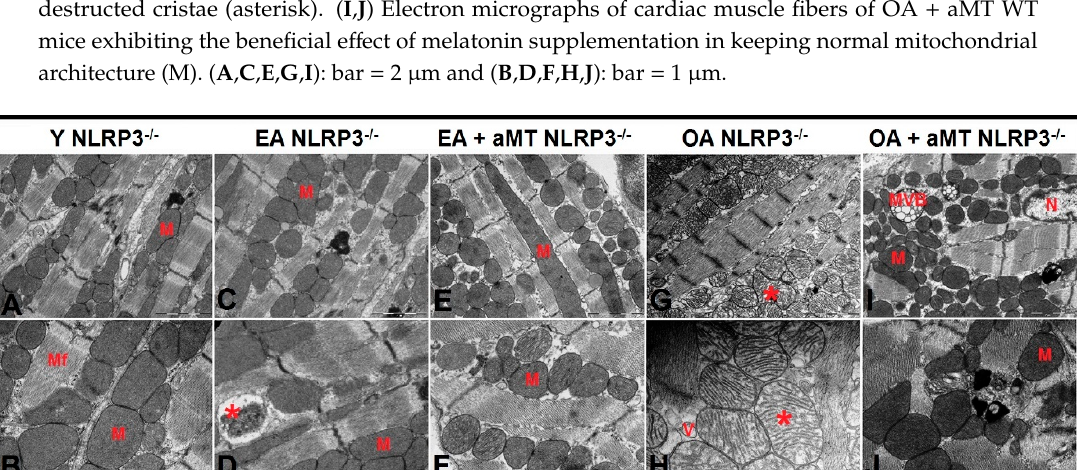
Figure 7. Age-related ultrastructural changes of mitochondria in cardiac muscle fibers of NLRP3 − / − mice and melatonin treatment. ( A , B ) Electron micrographs of cardiac muscle fibers of Y NLRP3 − / − mice showing the presence of normally highly compacted mitochondria with densely packed cristae (M) distributed among myofibrils (Mf). ( C , D ) Electron micrographs of cardiac muscle fibers of EA NLRP3 − / − mice demonstrating intact mitochondria (M) with individual ones depicting damaged peripherally cristae (asterisk). ( E , F ) Electron micrographs of cardiac muscle fibers of EA + aMT NLRP3 − / − mice revealing the clearly apparent prophylactic e ff ect of melatonin supplementation in keeping normal mitochondrial architecture (M) with aging. ( G , H ) Electron micrographs of cardiac muscle fibers of OA NLRP3 − / − mice indicating less detectable mitochondrial damage compared with WT mice, with the presence of numerous mitochondria showing widely-separated organized cristae (asterisk) and small-sized membranous vacuoles of possibly autophagic nature (V). ( I , J ) Electron micrographs of cardiac muscle fibers of OA + aMT NLRP3 − / − mice showing the protective e ff ect of melatonin supplementation in preserving normal mitochondrial structure (M), with formation of multivesicular bodies (MVB), which reflect the induction of the autophagic processes, N; nucleus. ( A , C , E , G , I ): bar = 2 µ m and ( B , D , F , H , J ): bar = 1 µ